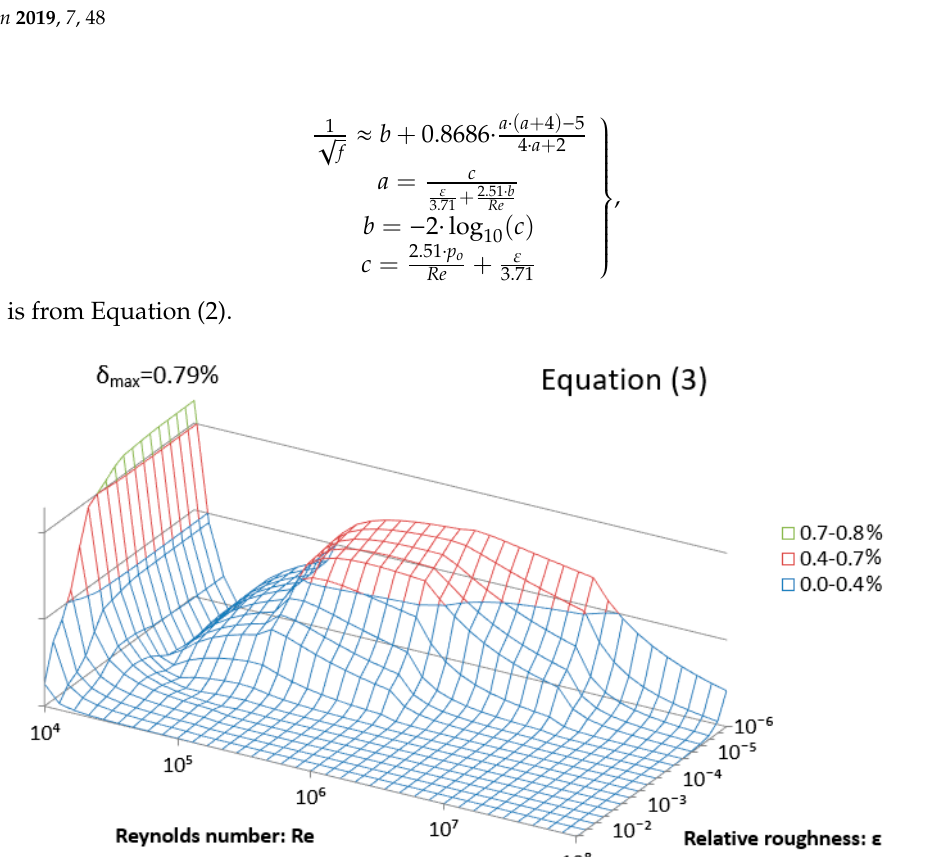
Figure 2. Distribution of the relative error for the approximation with one internal cycle and a fixed starting point.